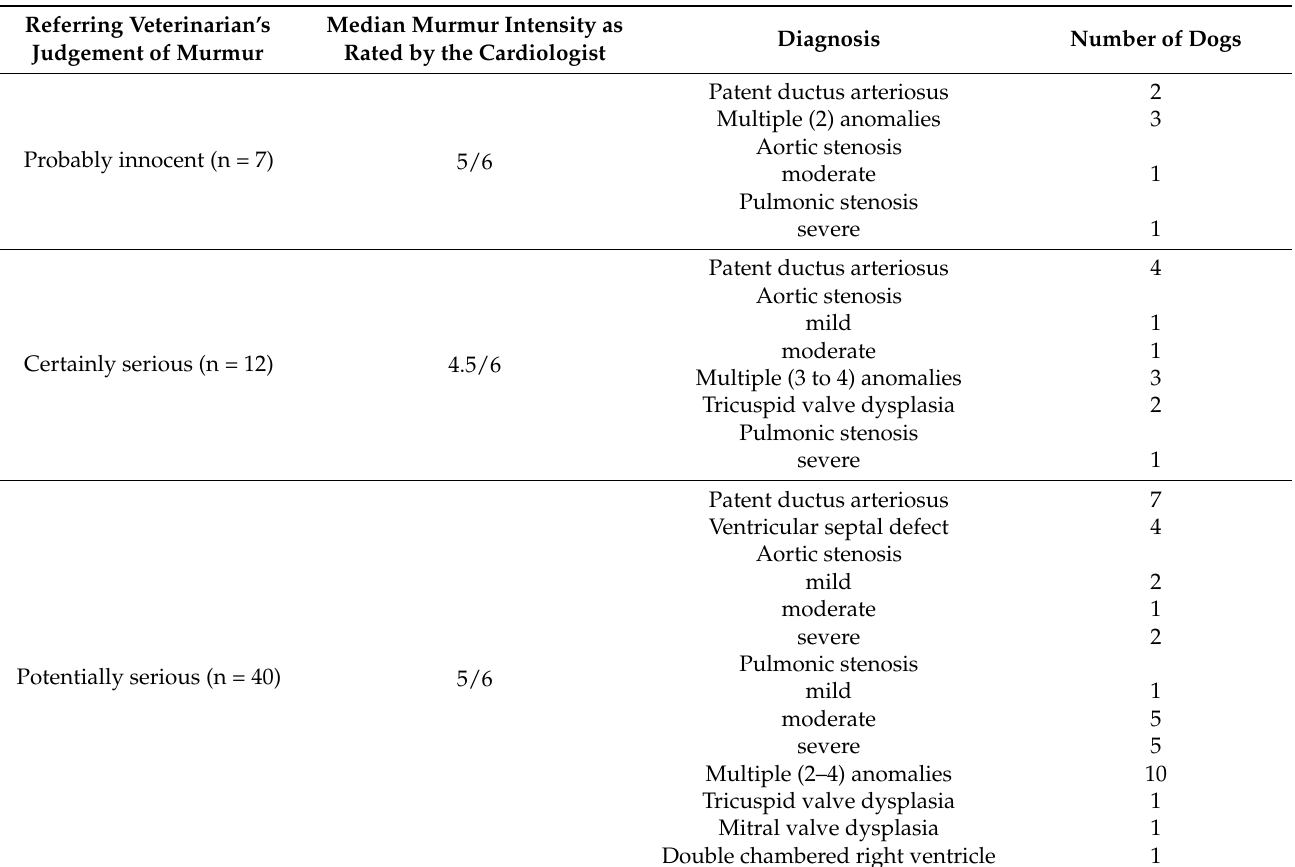
Table 2. The referring veterinarians’ assessment of the meaning of the murmur in 73 dogs with a congenital heart disease in relation to the final diagnosis and murmur intensity, as assessed by the cardiology